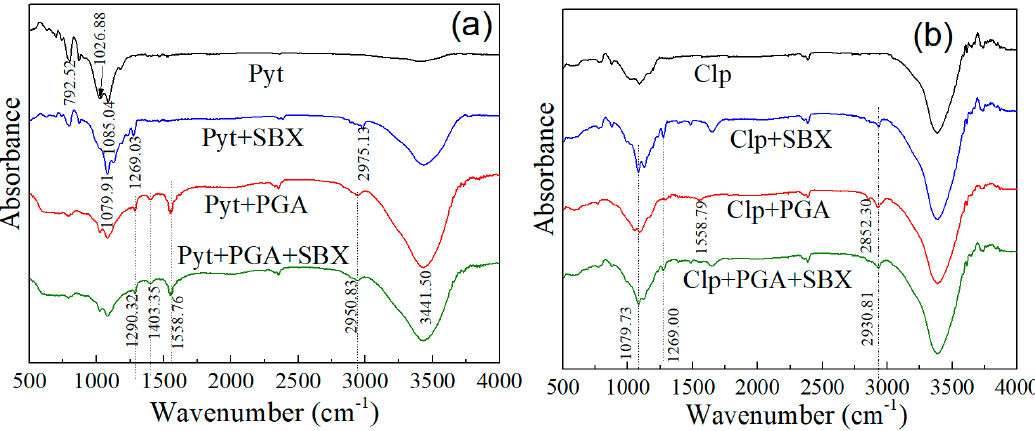
Figure 8. Infrared spectral results of ( a ) pyrrhotite (Pyt) and ( b ) chalcopyrite (Clp) at 50 mg/L PGA, 20 mg/L SBX, and pH 8.